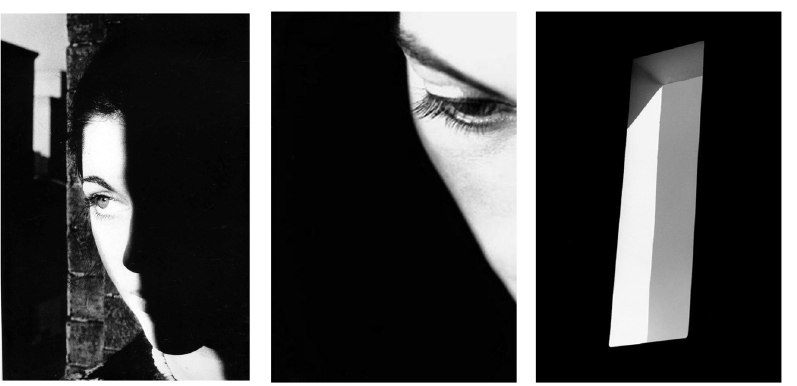
Figure 2. Examples of gestalt photographic works by Ralph Gibson Eye